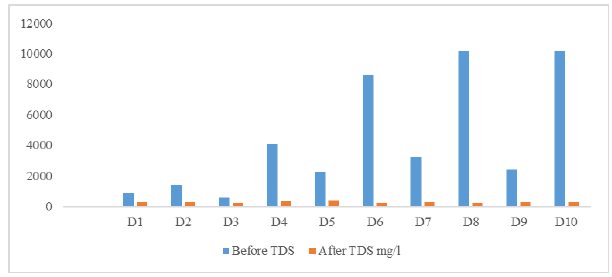
Fig. 7. TDS of Samples before and after Treatment, Diplo City